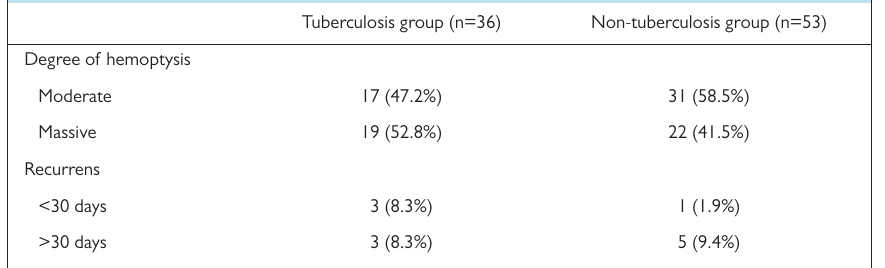
Table 4. Degree of hemoptysis and recurrence